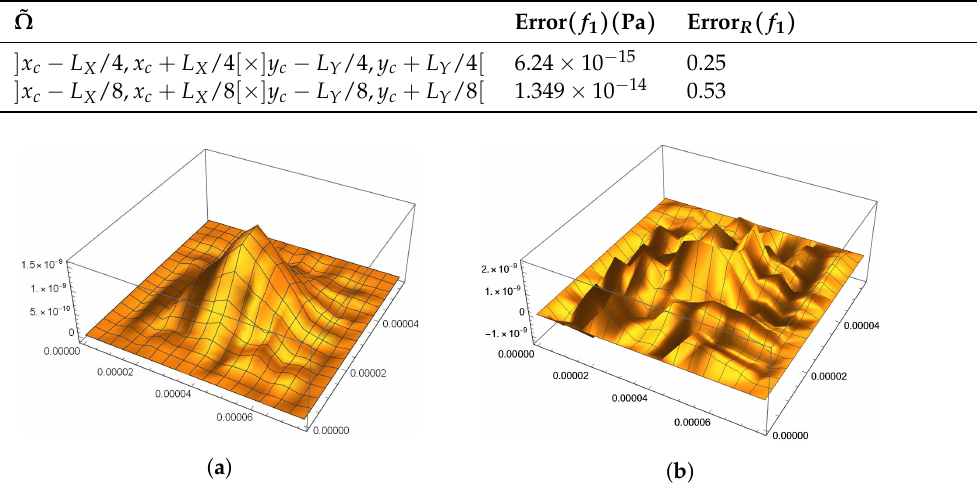
Figure 7. Comparison of the reconstruction results when we vary the position of the observation